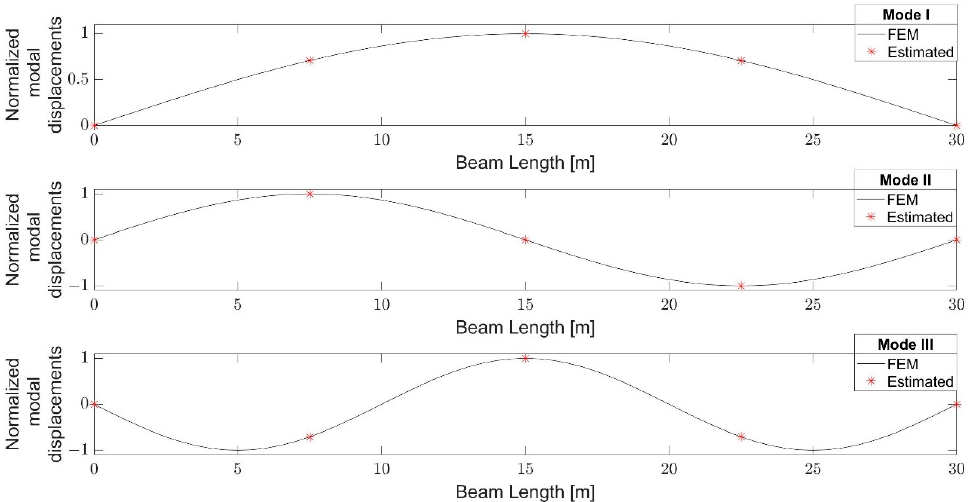
Figure 4. Estimated vs. theoretical modal displacements (no roughness, no noise).